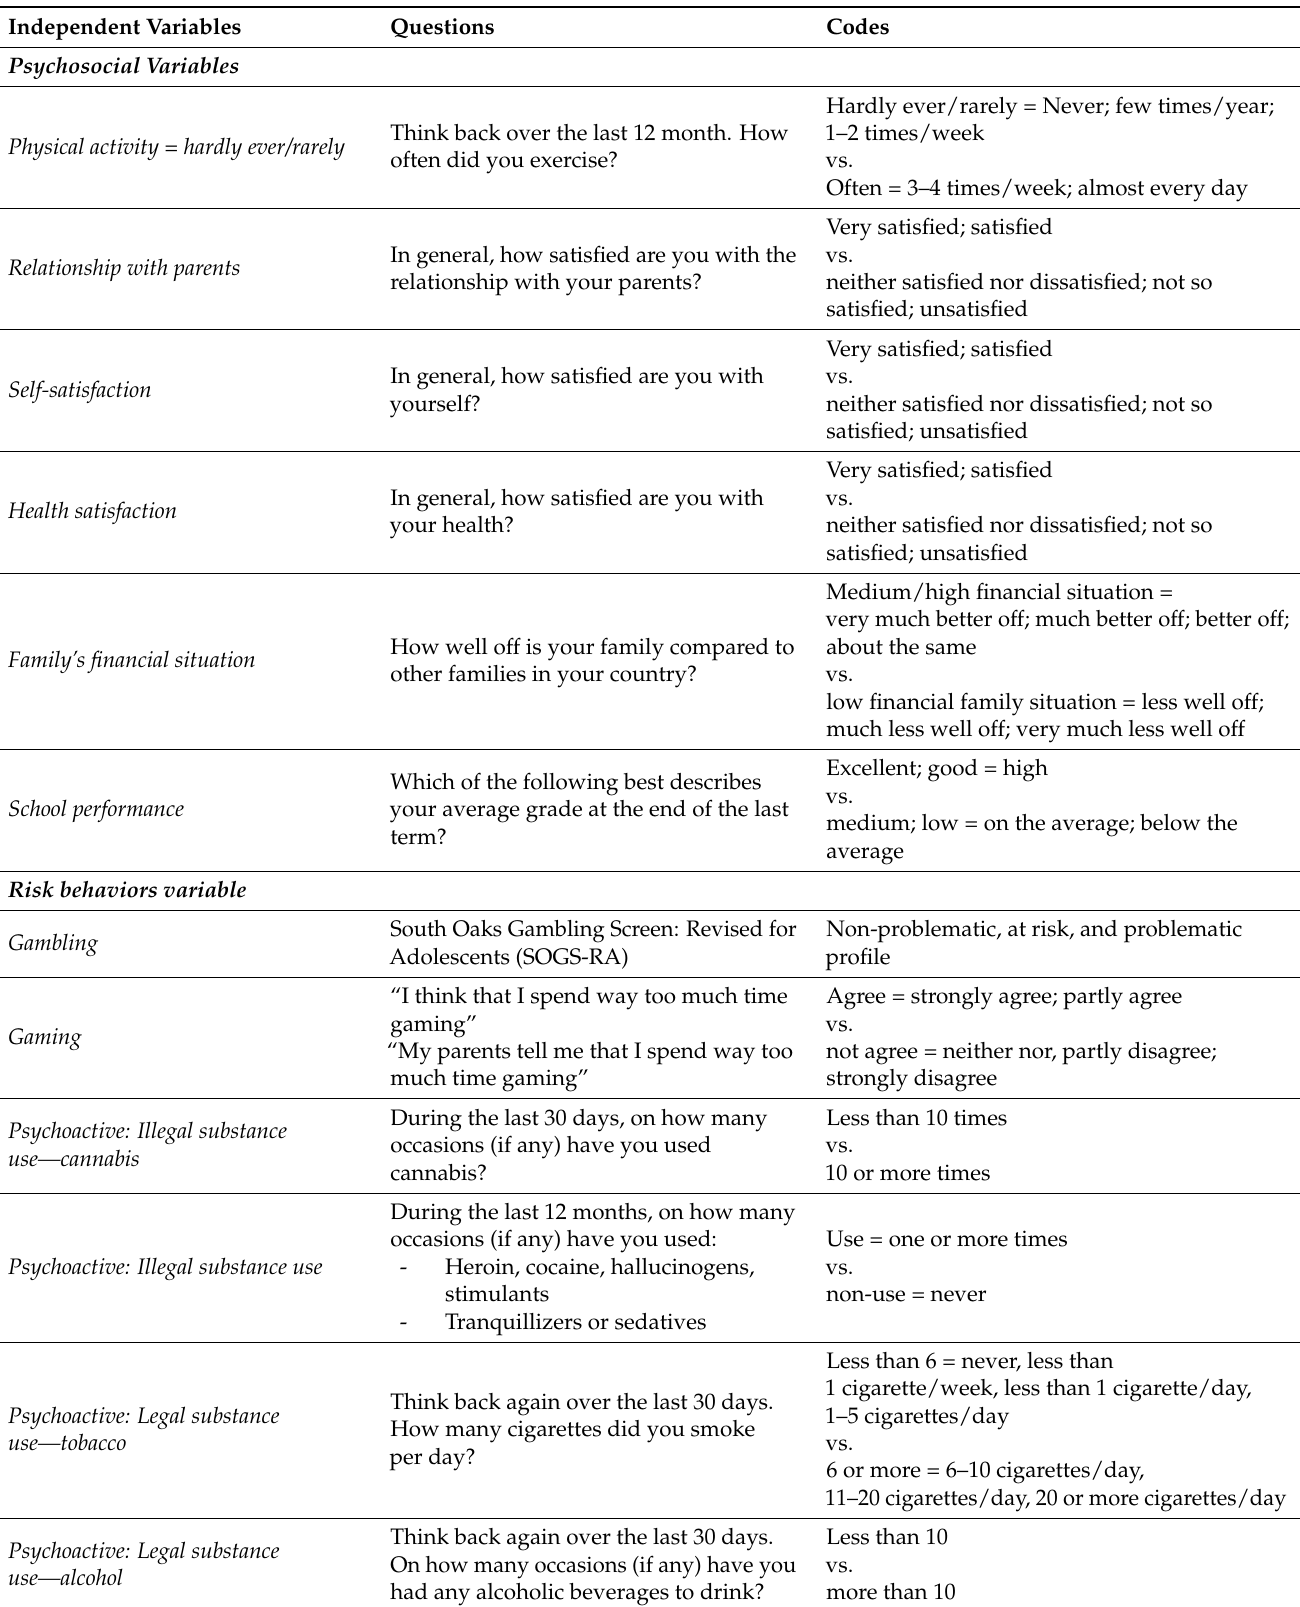
Table 1. Independent variables considered (except age), questions, and